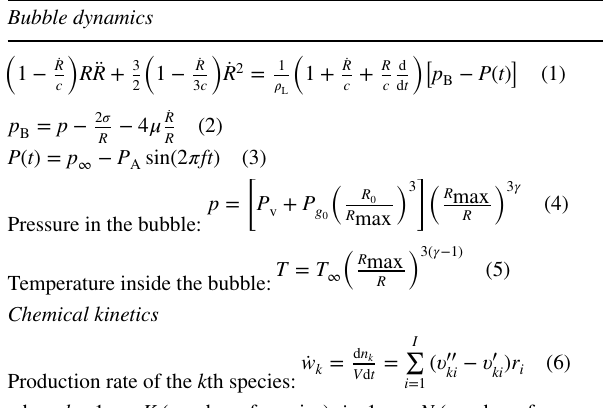
Table 1 Basic equations of the model (Merouani et al. 2014a,